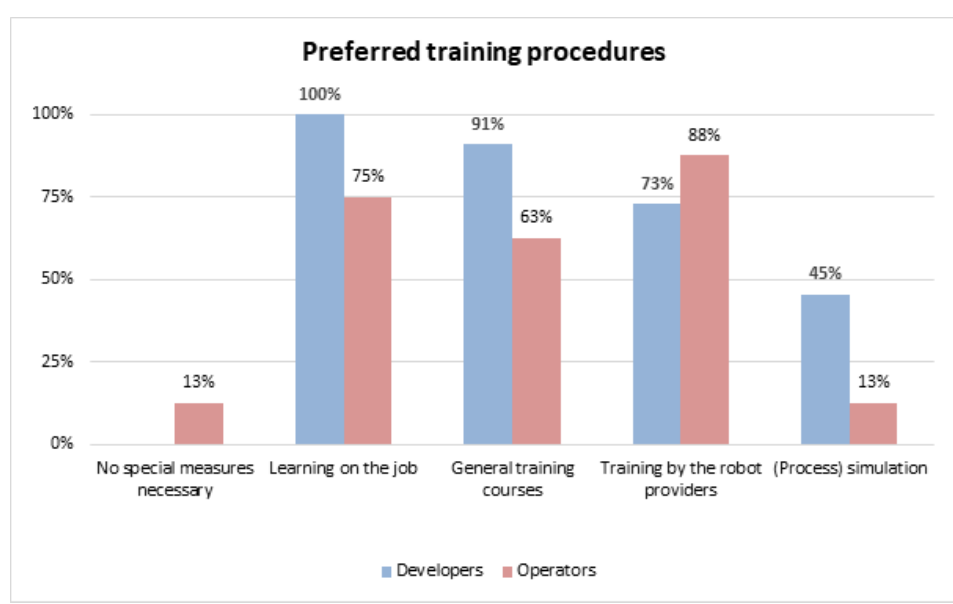
Figure 9. Preferences on training approaches (percentage of answers).